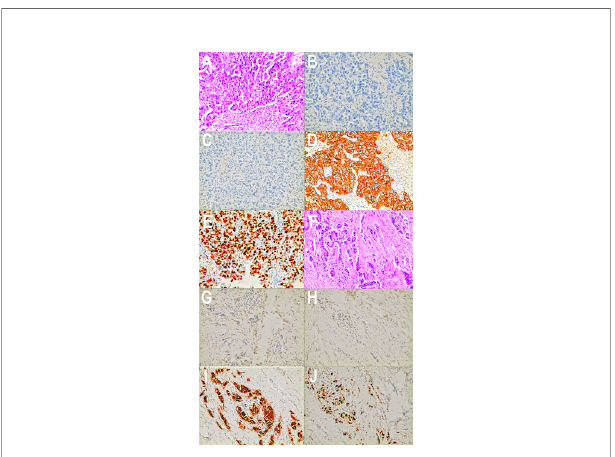
FIGURE 2 | Pathology images and immunotherapy staining images of this patient. (A) Pathology images of core needle biopsy in October 2017. (B) ER immunotherapy staining image of core needle biopsy in October 2017. (C) PR immunotherapy staining image of core needle biopsy in October 2017. (D) HER2 immunotherapy staining image of core needle biopsy in October 2017. (E) Ki-67 immunotherapy staining image of core needle biopsy in October 2017. (F) Pathology images of mastectomy in January 2019. (G) ER immunotherapy staining image of mastectomy in January 2019. (H) PR immunotherapy staining image of mastectomy in January 2019. (I) HER2 immunotherapy staining image of mastectomy in January 2019. (J) Ki-67 immunotherapy staining image of mastectomy in January